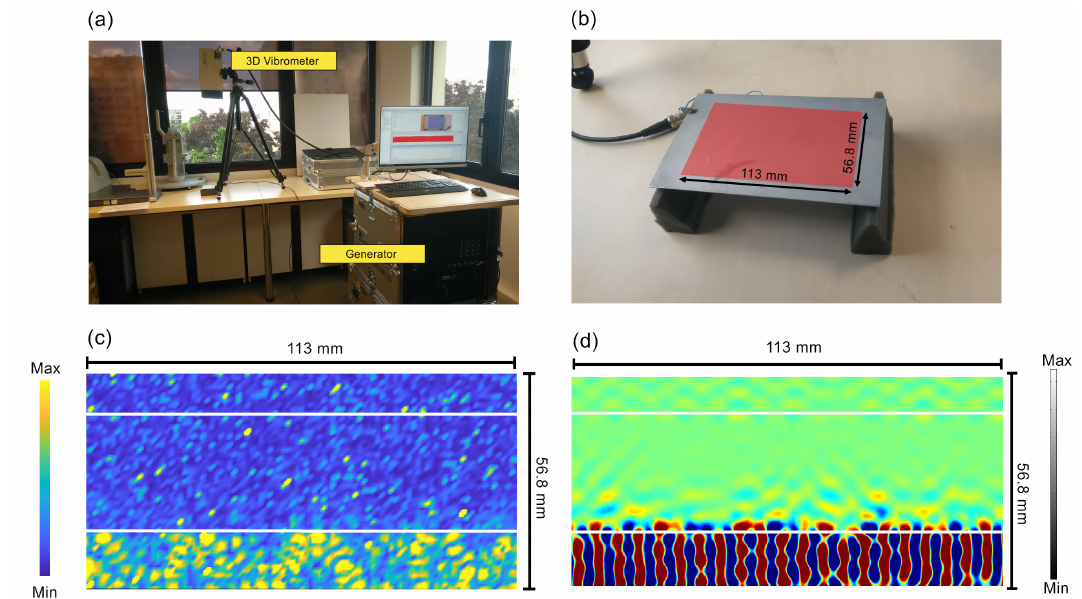
Figure 3. ( a ) PSV-500 set-up to measure the surface cartography displacement for demultiplexer device, ( b ) scanning area (red region) equivalent to 113 mm × 56.8 mm surface dimension, ( c ) experimental surface measurement at the band gap frequency, f = 265 kHz, ( d ) simulated displacement at similar band gap frequency, as ( c ). The white lines mark the boundaries of the pillar based phononic crystal in both ( d ) and ( c